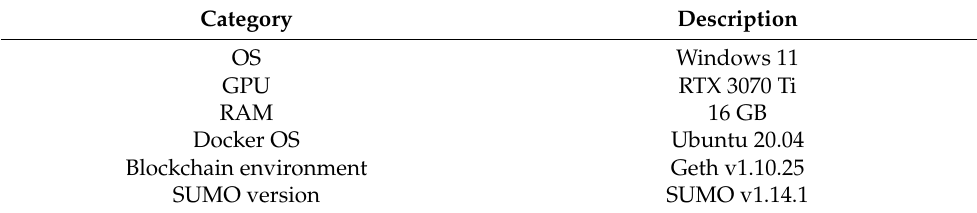
Table 3. Simulation and experimental environment.